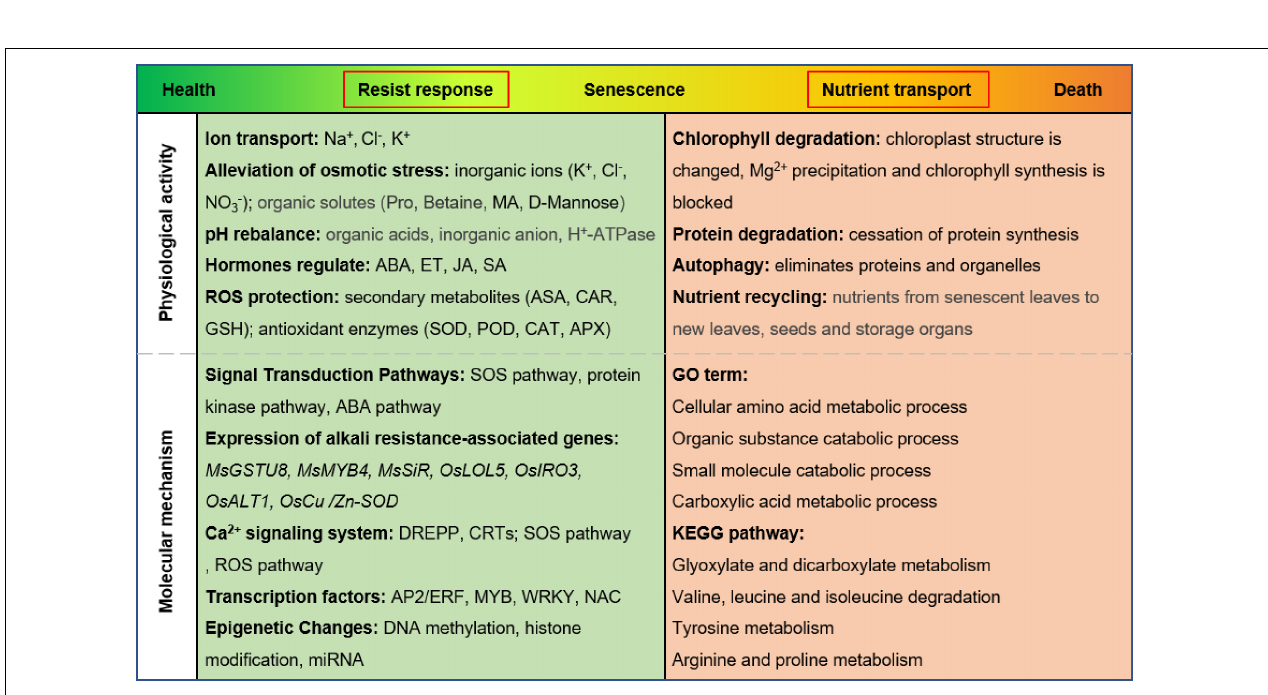
FIGURE 8 | A model of leaf senescence regulation under alkaline stress in M. truncatula.